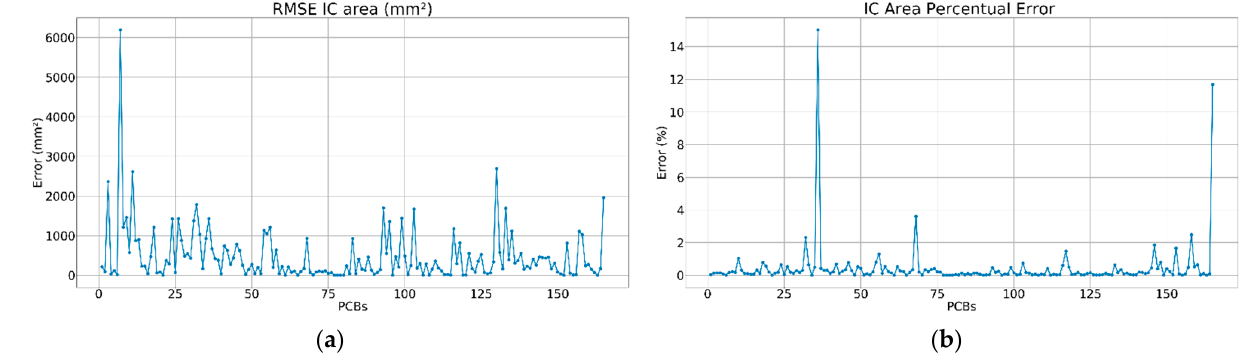
Figure 8. Root mean squared error (RMSE) for every WPCB in the dataset ( a ) and IC area percentual error for every WPCB in the dataset ( b ).